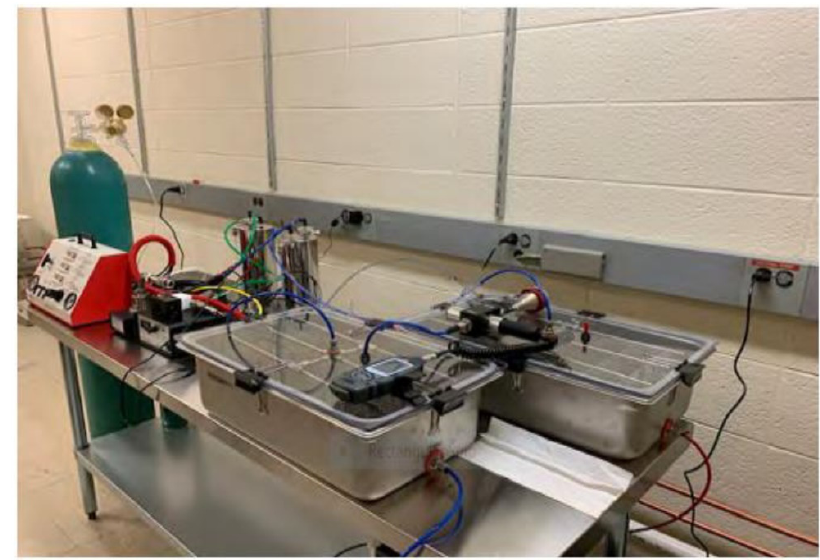
Figure 8. Airborne, whole body particulate matter exposure chamber.